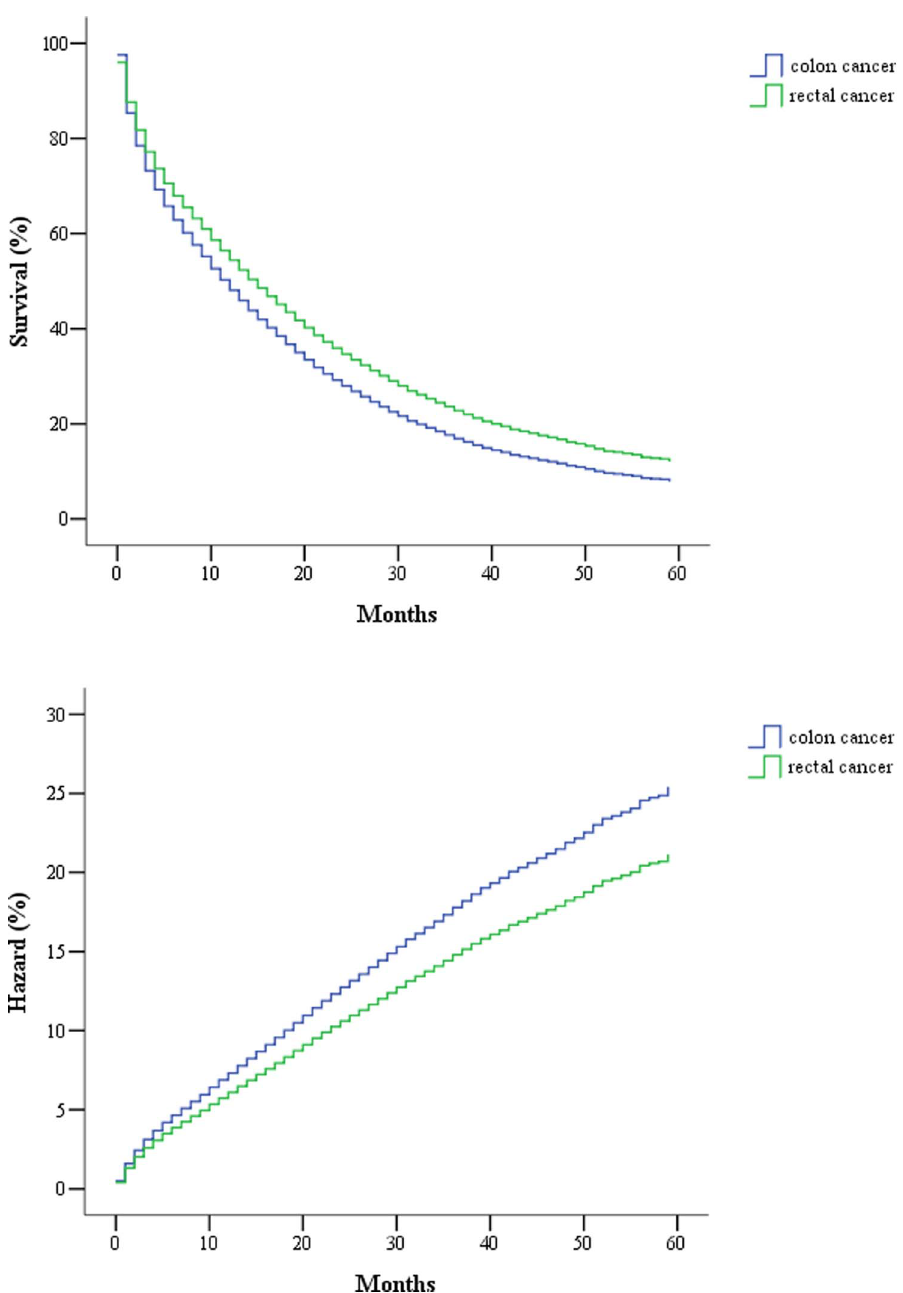
Figure 7. Survival and cumulative hazard in Cox regression model of stage IV colon and rectal cancer patients.